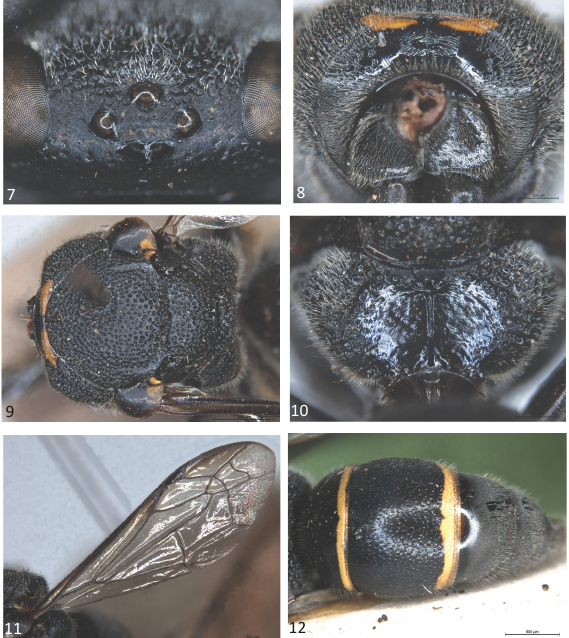
the base of clypeus, a small spot on ocular sinus at lower eye margin, an elongated spot on upper part of temple near to eye margin, a median interrupted transverse band on pronotum, two spots on tegula at both apex, a small spot on the apex of forefemur, an elongated mark on hind tibia at inner side and narrow transverse band at the apex of T1 and T2, the band on T2 slightly thicker than T1 (Image 12). Apex of mandible and apical tarsal segments blackish brown. Wings hyaline, thickly infumated at stigma (Image 11), slightly infumated at the apex of median cell and upper half of radial cell; veins brown. Body with rather sparsely to